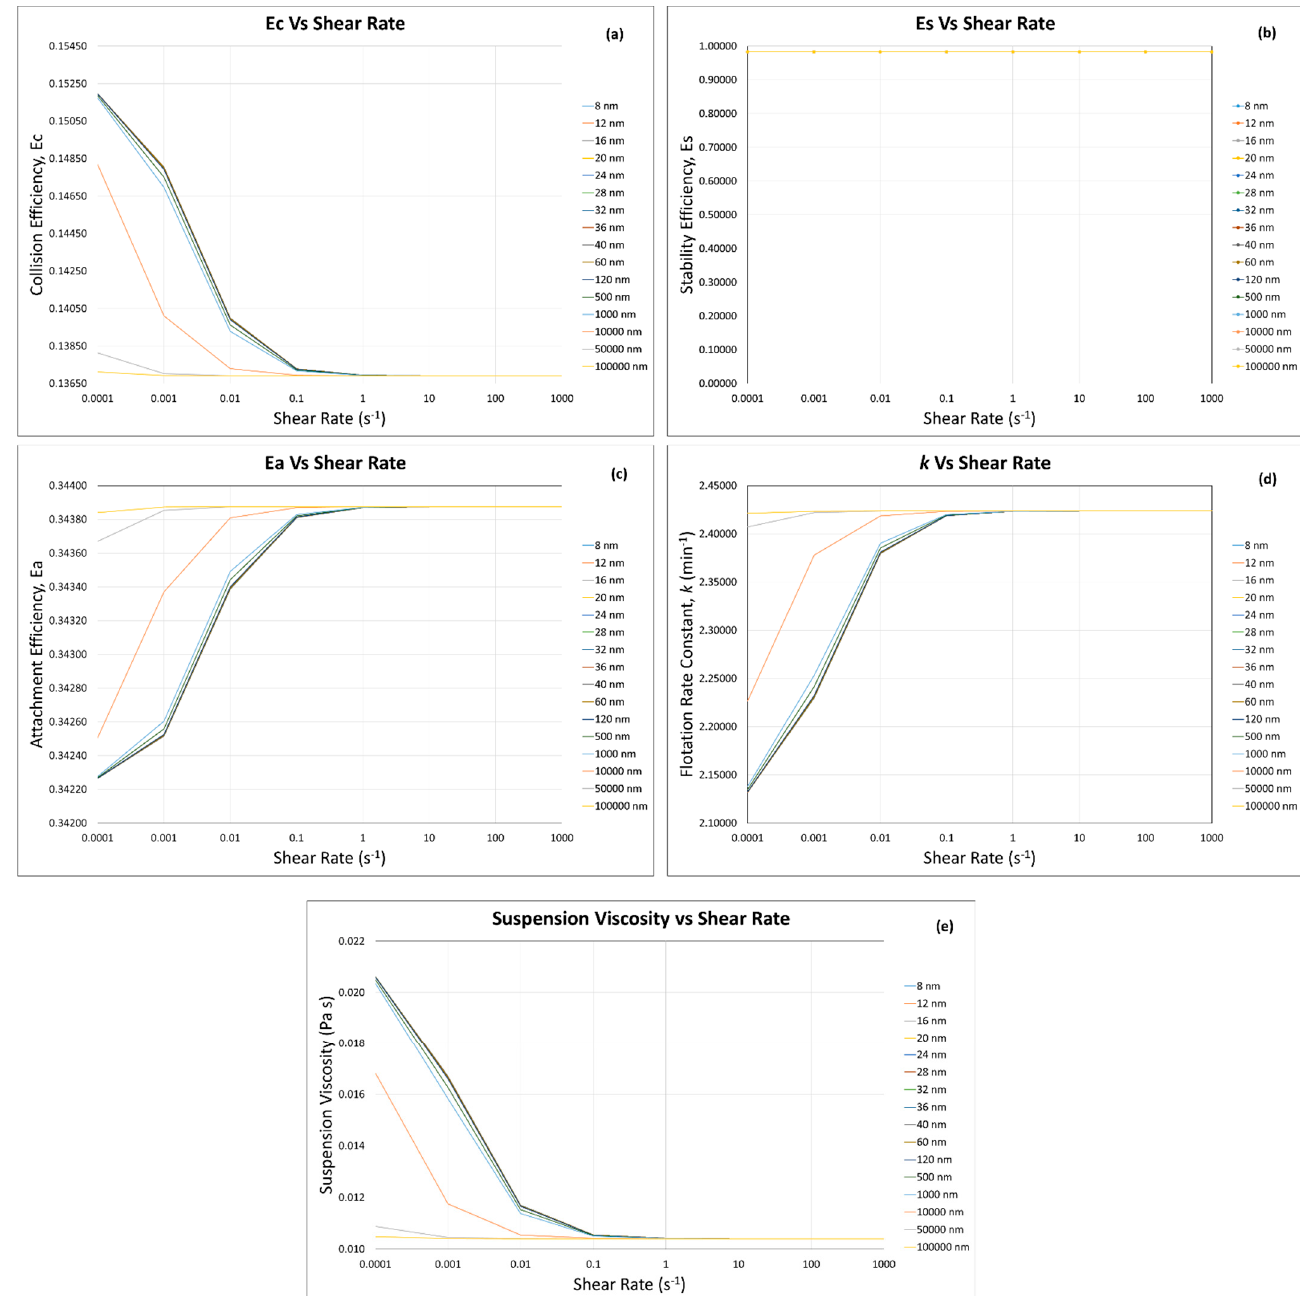
Figure 13. Flotation efficiencies: ( a ) collision, ( b ) stability, ( c ) attachment, and ( d ) rate constant by using ( e ) the suspension viscosity calculated by the predictive model (same particles with different sizes ( 𝑎 (cid:2869) : 𝑎 (cid:2870) = 1: 9 ), at 𝜙 = 0.5 ).